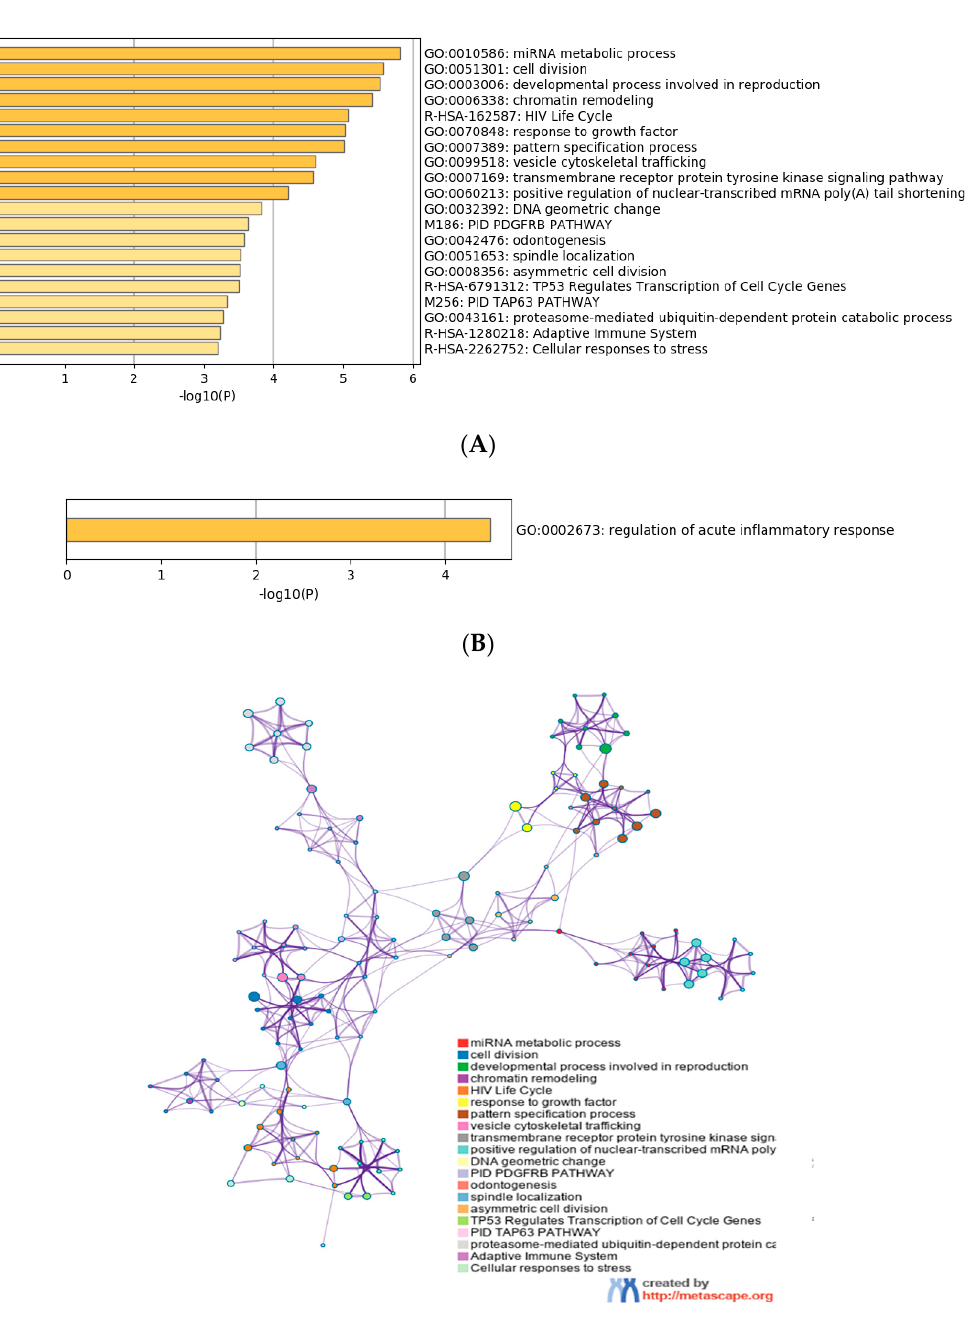
Figure 4. Analysis of the functional enrichment of target genes. ( A , B ) The main enrichment analysis clusters detected by Metascape of genes associated with upregulated miRNA after treatment with OMVs; ( C ) interaction network of the clusters detected by Metascape. The nodes of the same colour belong to the same cluster. Terms with a similarity score > 0.3 are linked by an edge. The network is visualized with Cytoscape (v3.1.2) with a “force-directed” layout and edge bundled for